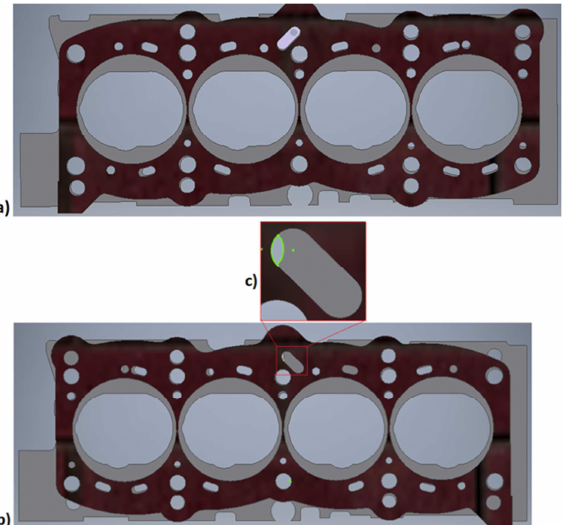
Fig. 4. Model of the controlled oil volume. a) (Inlet) – place of oil supply to the channel in the cylinder head, b) (Outlet 1, Outlet2, Outlet3) – oil outlets into friction contact zones in camshaft bearings